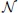
Comparison of the autocorrelation functions.Autocorrelation function of a sampled normal process Ne
(0, Δ t) with sampling interval of 1 minute (upper panel) and of the 1-minute returns observed on March 4, 2013 (lower panel).